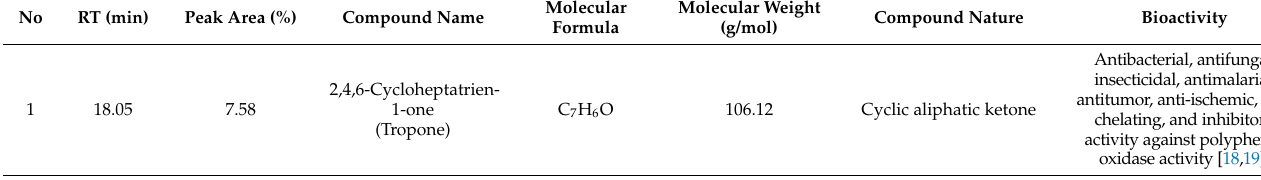
Table 1. GC-MS analysis of phytochemicals in B. rufescens stem bark methanol